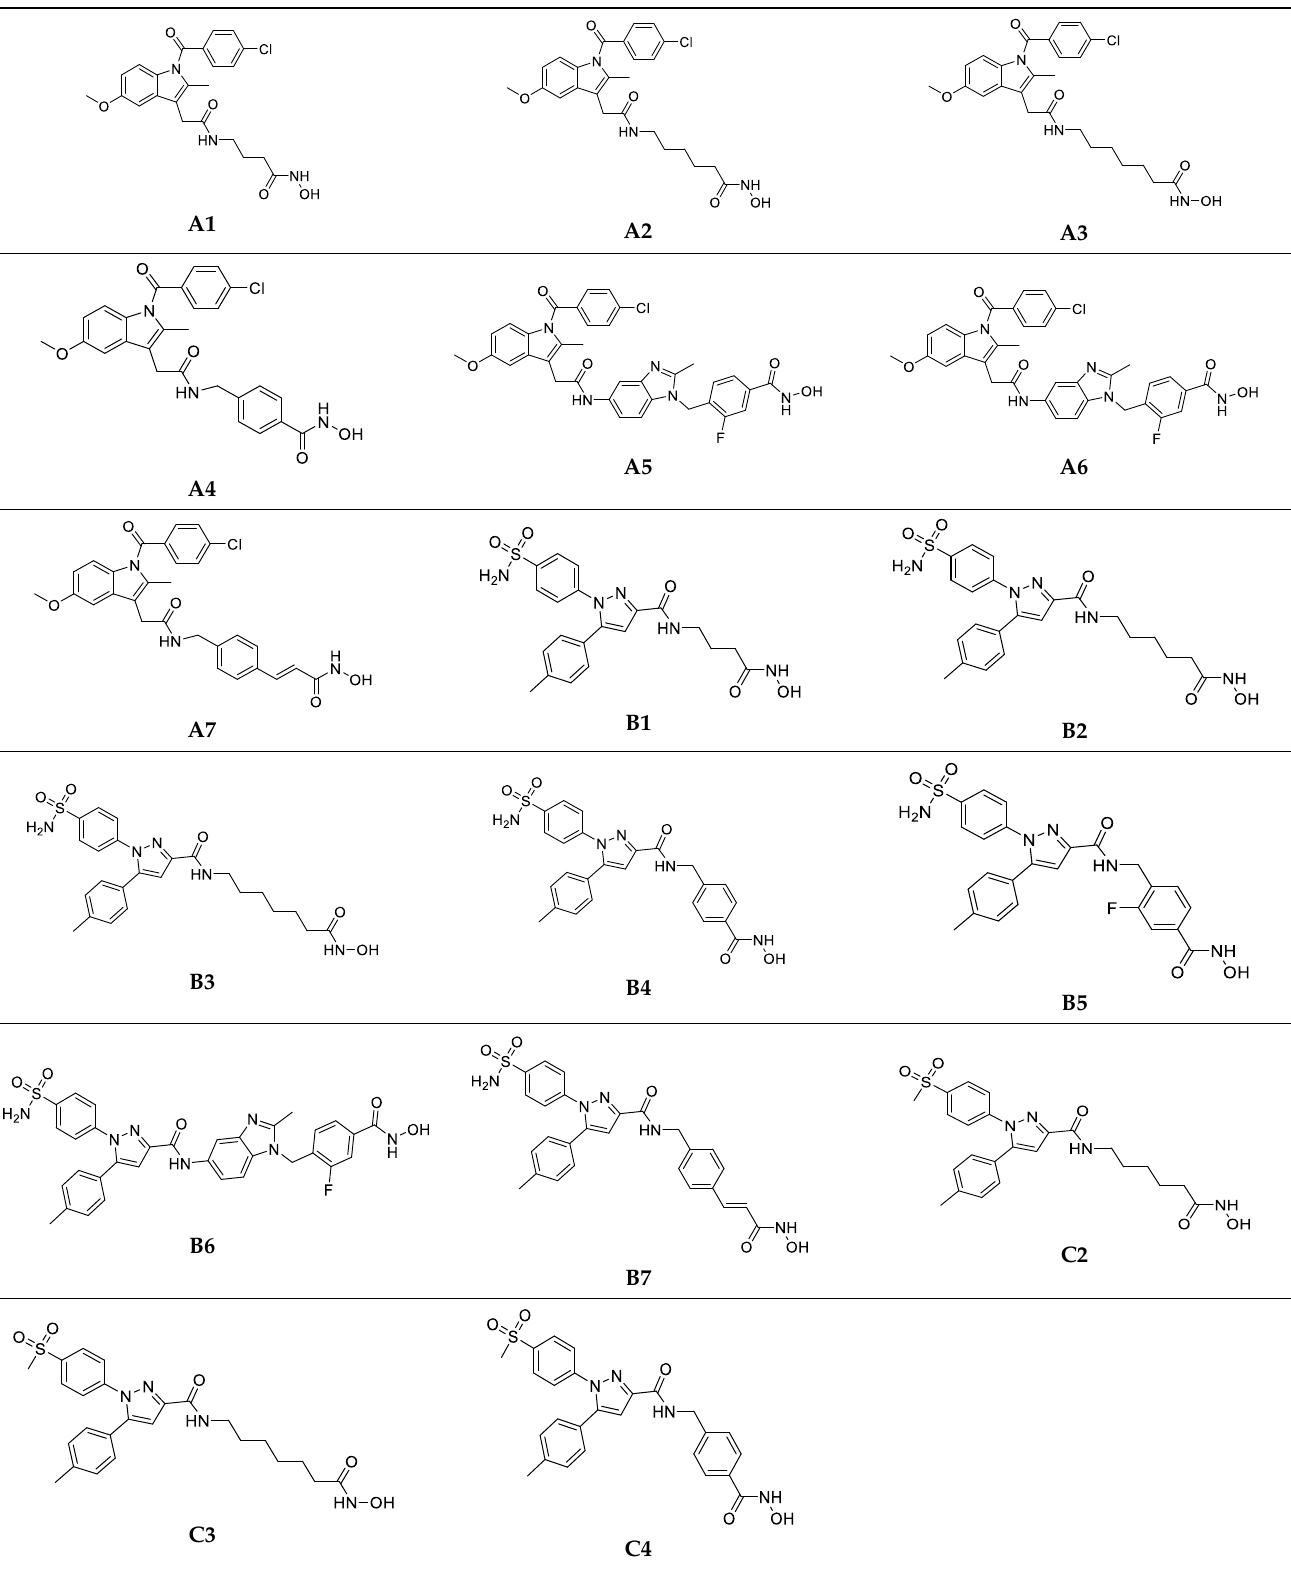
Table 1. Chemical structures of A1–A7 , B1–B7 , and C2–C4 . Table 1. Chemical structures of A1 – A7 , B1 – B7 , and C2 – C4 . Table 1. Chemical structures of A1 – A7 , B1 – B7 , and C2 – C4 . Table 1. Chemical structures of A1 – A7 , B1 – B7 , and C2 – C4 . Table 1. Chemical structures of A1 – A7 , B1 – B7 , and C2 – C4 . Table 1. Chemical structures of A1 – A7 , B1 – B7 , and C2 – C4 . Table 1. Chemical structures of A1 – A7 , B1 – B7 , and C2 – C4 . Table 1. Chemical structures of A1 – A7 , B1 – B7 , and C2 – C4 . Table 1. Chemical structures of A1 – A7 , B1 – B7 , and C2 – C4 . Table 1. Chemical structures of A1 – A7 , B1 – B7 , and C2 – C4 . Table 1. Chemical structures of A1 – A7 , B1 – B7 , and C2 – C4 . Table 1. Chemical structures of A1 – A7 , B1 – B7 , and C2 – C4 . Table 1. Chemical structures of A1 – A7 , B1 – B7 , and C2 – C4 . Table 1. Chemical structures of A1 – A7 , B1 – B7 , and C2 – C4 . Table 1. Chemical structures of A1 – A7 , B1 – B7 , and C2 – C4 Table 1. Chemical structures of A1 – A7 , B1 – B7 , and C2 – C4 .